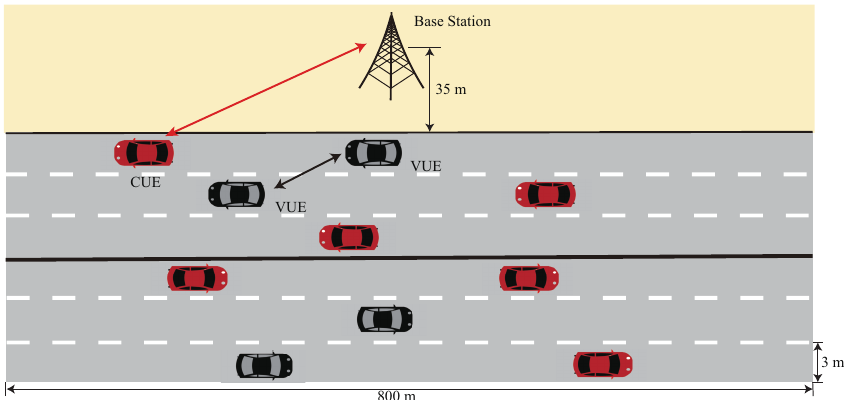
Figure 4. Simulation scenario